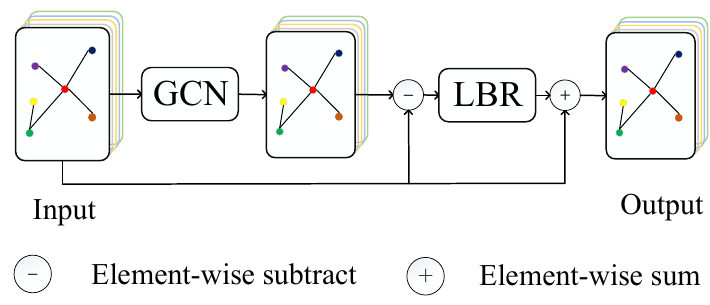
Figure 3. Offset graph convolution module (OGC).